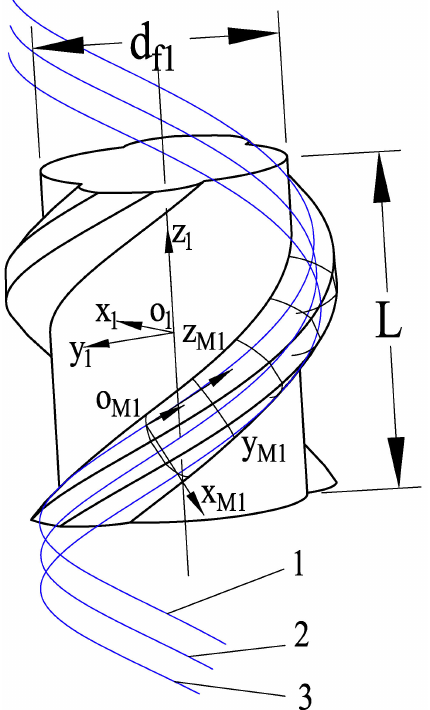
Figure 2. Schematic diagram of the driving line